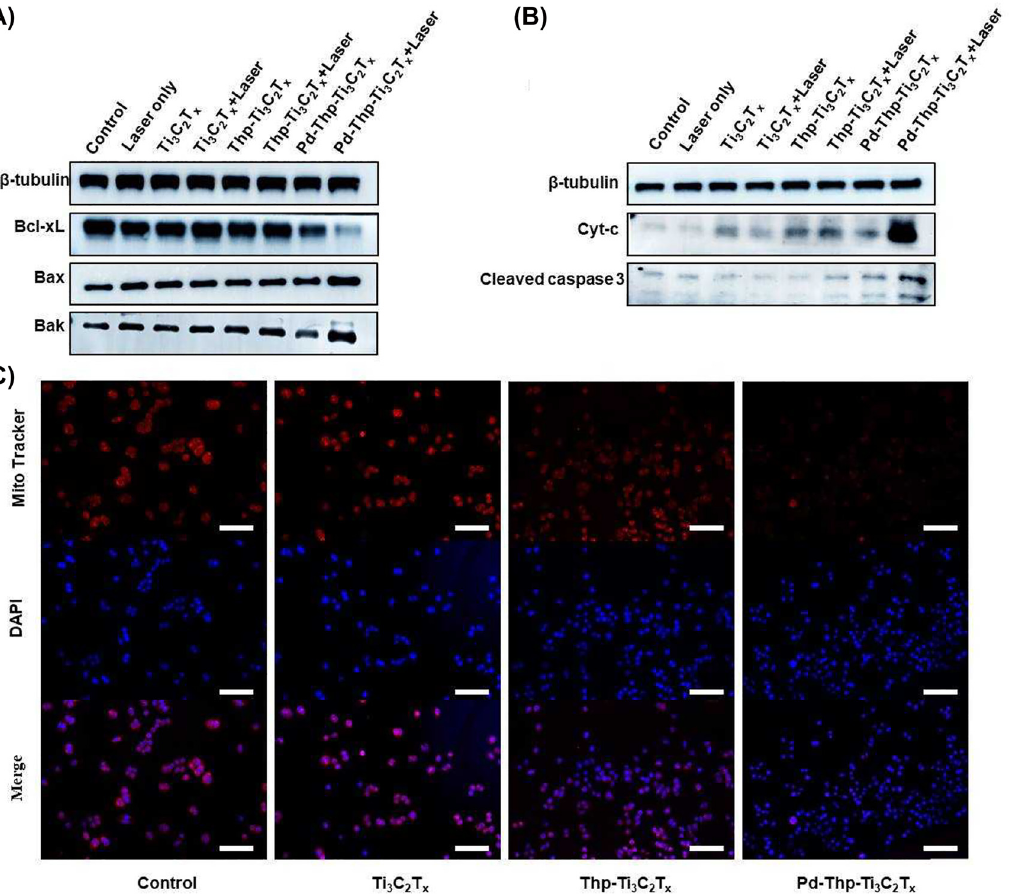
Figure 5: (A) Expression of Bcl-2 family protein Bax, Bak and Bcl-xL by western blotting using SW480 cells. (B) Expression of Cyt-c and cleaved caspase 3 by western blotting using SW480 cells. (C) Cells treated with different composites were irradiated under 808 nm and stained with MitoTracker Red CMXRos. (Treatment condition: 12.5 ppm, 808 nm, 1.0 W/cm 2 , 5 min; scale bar: 100 𝜇